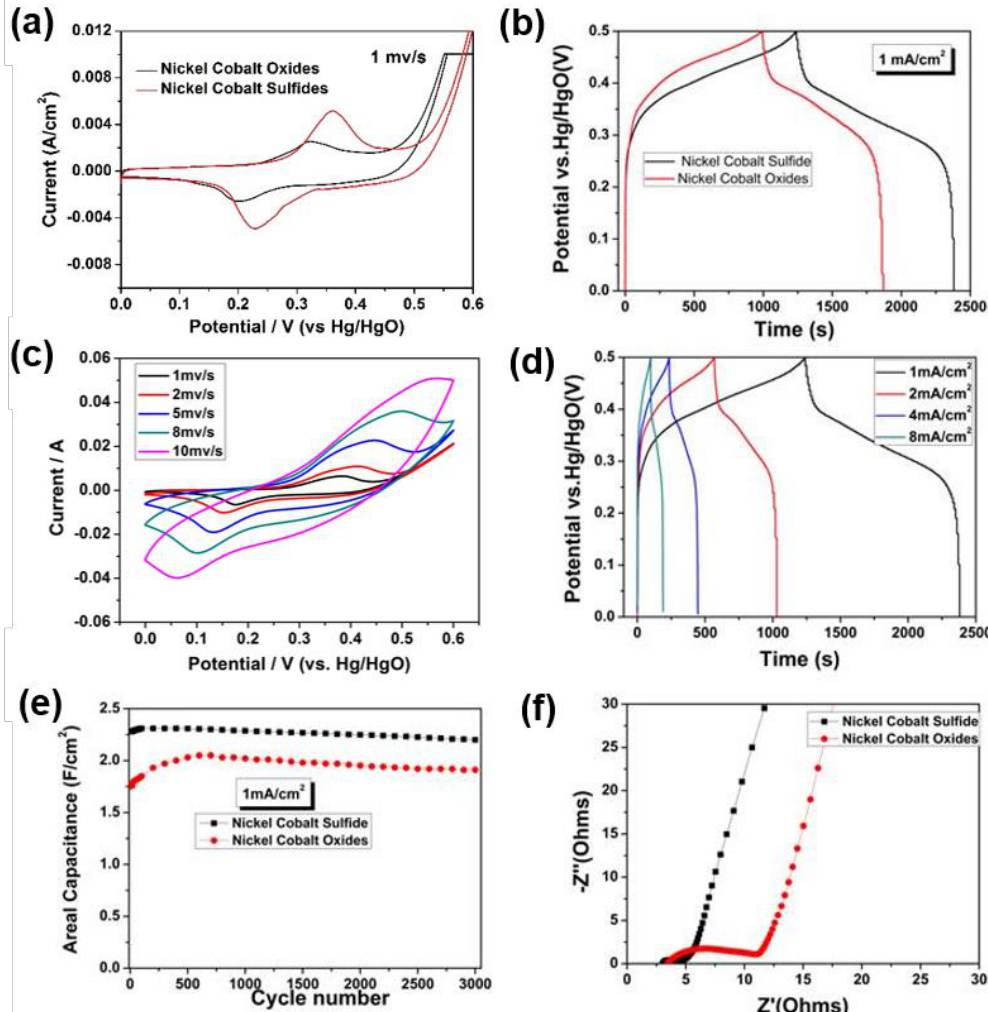
Figure 5. Electrochemical performance of Ni-Co sulfide electrode and the pristine NiCo 2 O 4 electrode. The electrochemical measurements were carried out in a 6 M KOH aqueous solution as electrolyte. ( a ) Cyclic voltammetry (CV) curves comparison, ( b ) Galvanostatic charge-discharge curves, ( c ) CV curve of Ni-Co sulfide electrode, ( d ) Galvanostatic charge-discharge measurements of Ni-Co sulfide electrode, ( e ) cycle performance comparison and ( f ) EIS curve comparison.